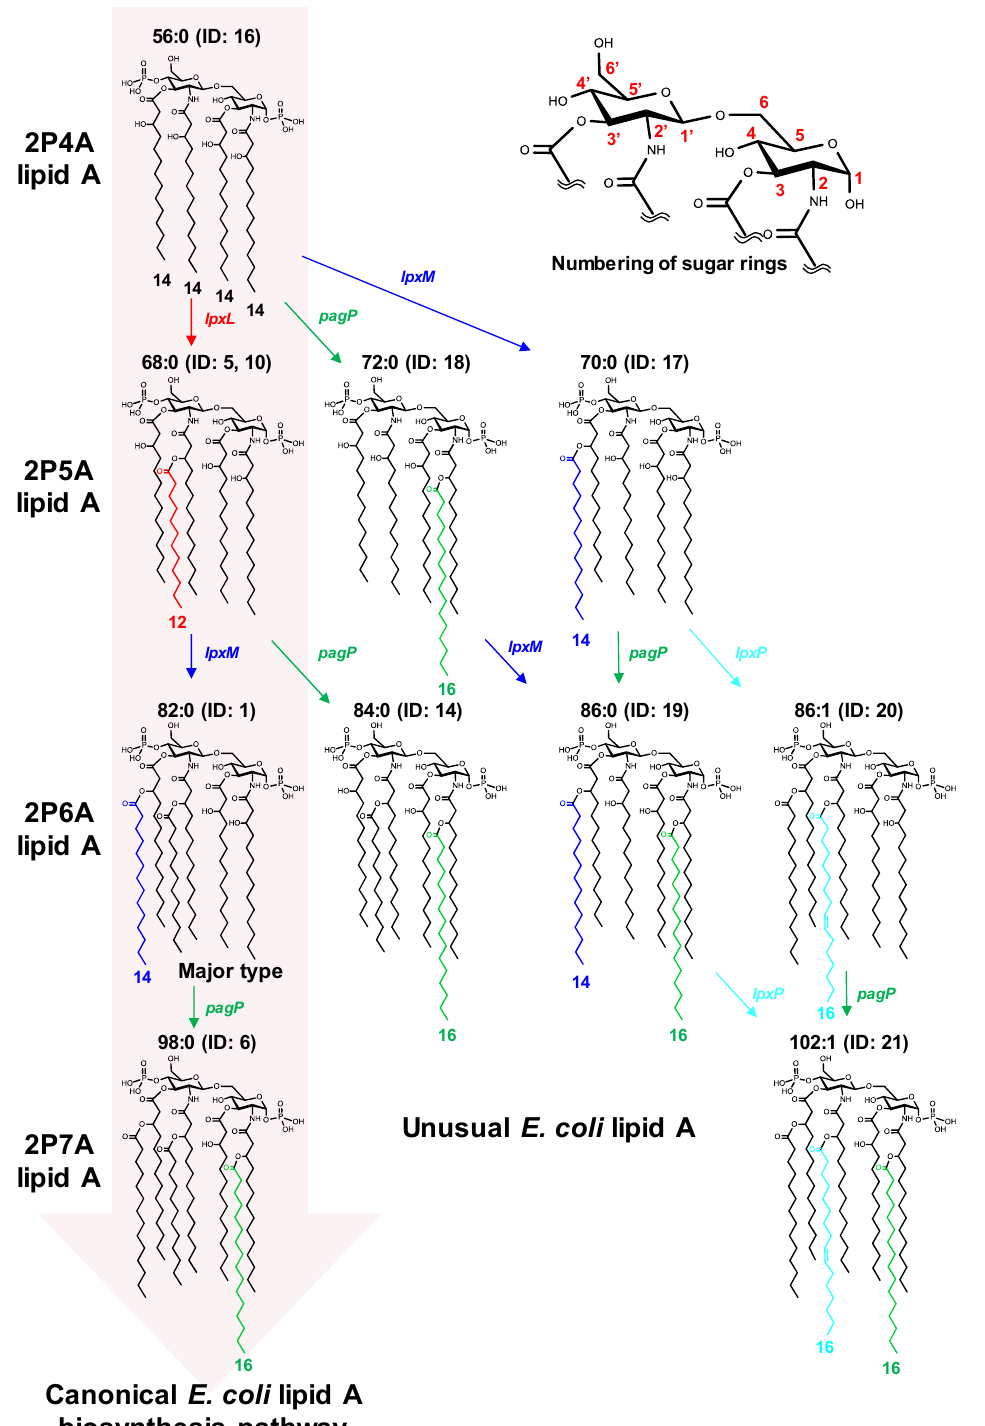
Figure 2. Canonical and proposed metabolic pathways of E. coli lipid A. The pink arrow indicates the canonical lipid A biosynthesis pathway in E. coli . A moiety of 3-deoxy- D -manno-octulosonic acid (kdo 2 ) linked to 6 ′ -O position and the reaction of kdo transferase are not shown. The upper right panel shows the numbering of the sugar rings. Carbon chain lengths are written under the acyl chain. Double bond positions in the structures of ID 20 and 21 were estimated from the literature [28].